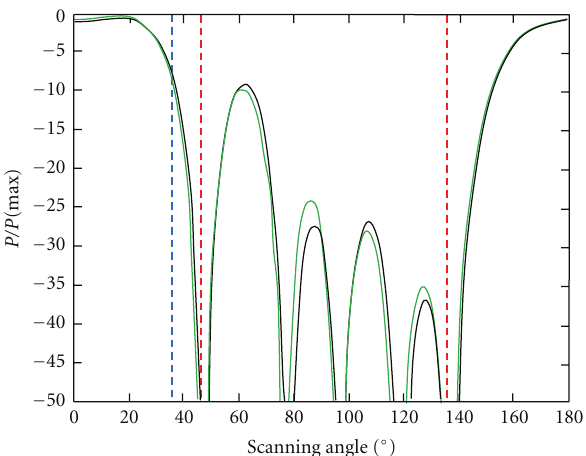
Figure 21: An ANN beam pattern pointed towards the useful signal with the angle of 35 degrees.